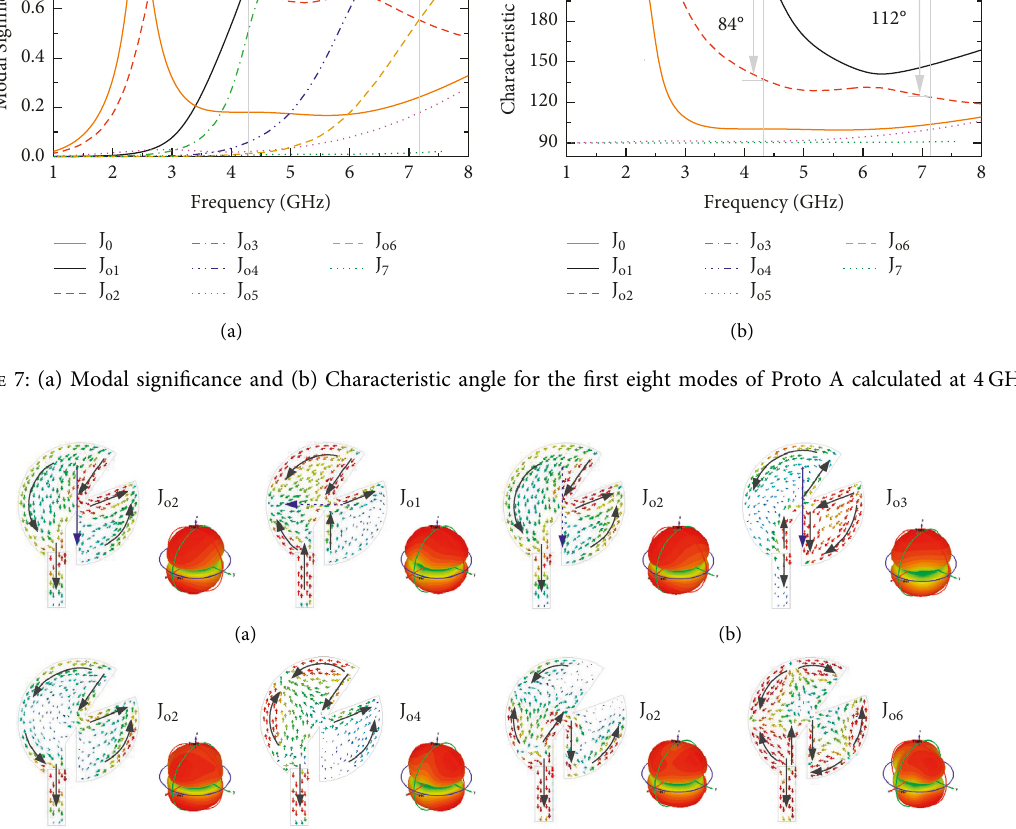
o 1 and J o 2 at 4.3GHz. (b) Modes J o 2 and J o 3 at 4.5GHz. (c)